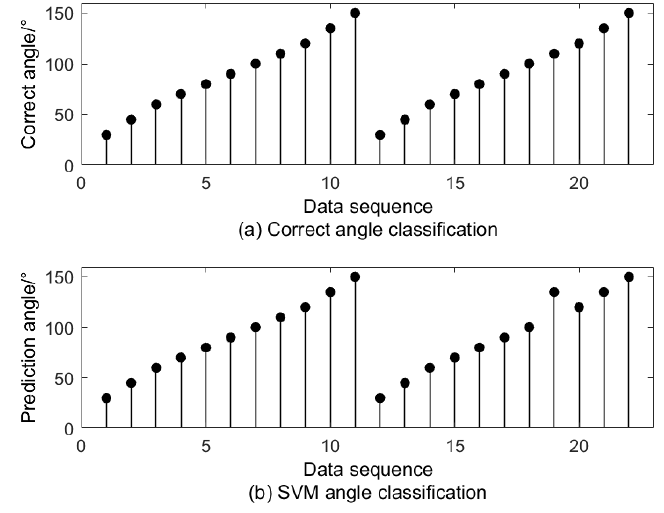
Figure 26. ( a ) Actual angle sequence; ( b ) prediction angle sequence.